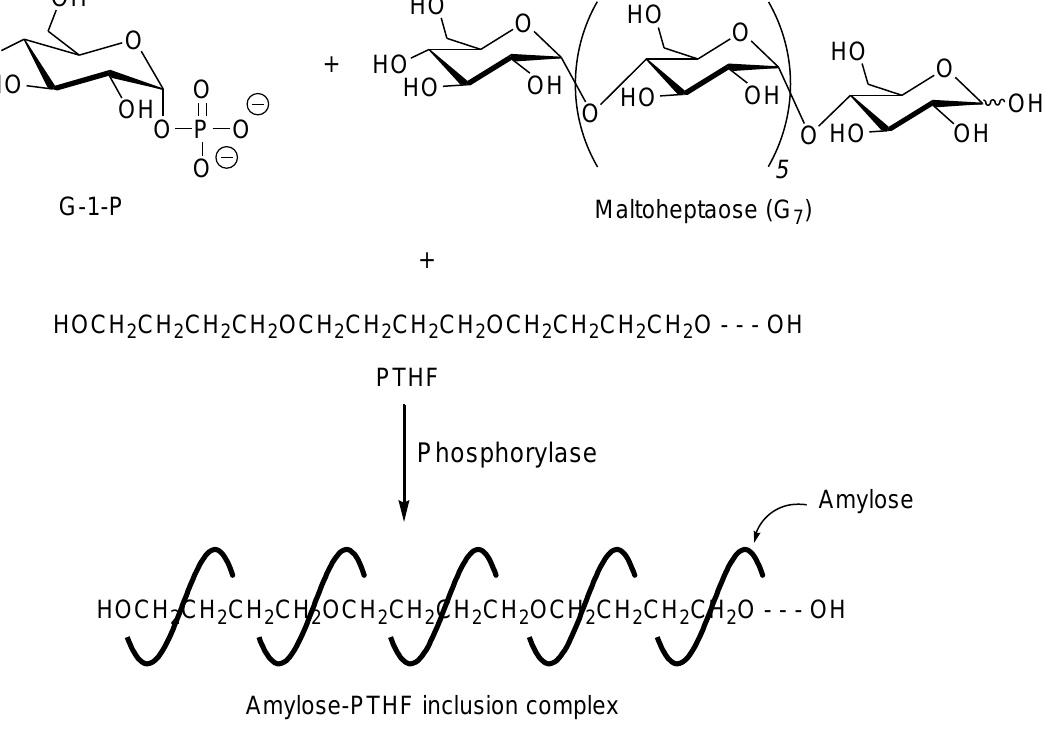
Figure 5. XRD profiles of amylose ( a ), amylose-PTHF inclusion complex ( b ), and amylose- poly( L -lactide) (PLLA) inclusion complex ( c